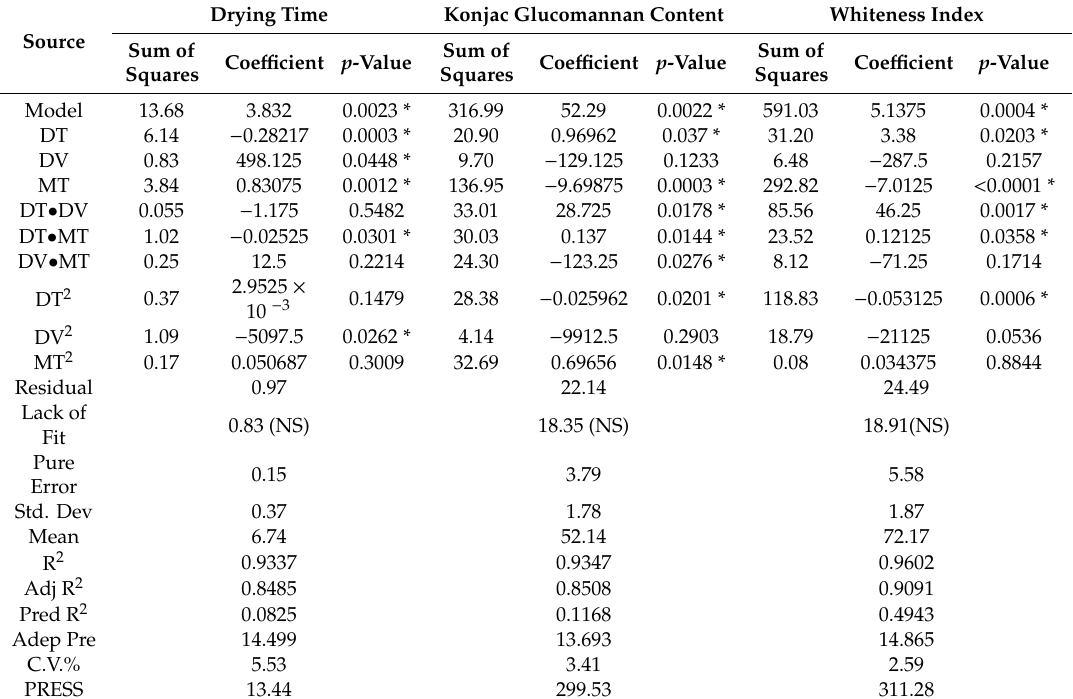
Table 3. ANOVA evaluation of linear, quadratic and interaction terms for response and coe ffi cient of prediction